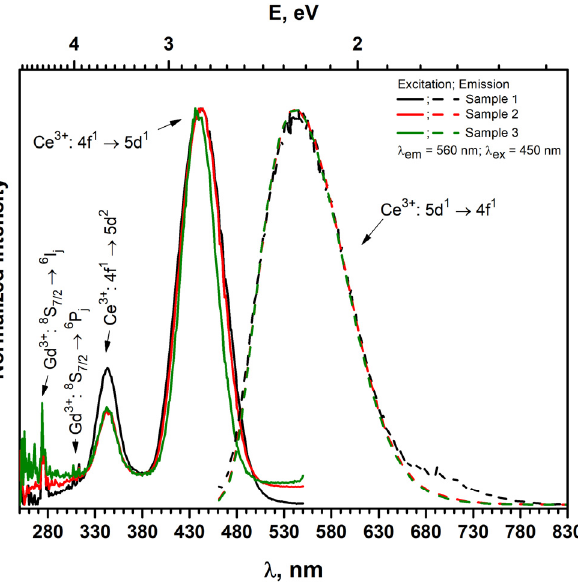
Figure 3 . Excitation and emission spectra of GAGG:Ce,Cr,Mg,Ca powder samples ( λ ex = 450 nm).